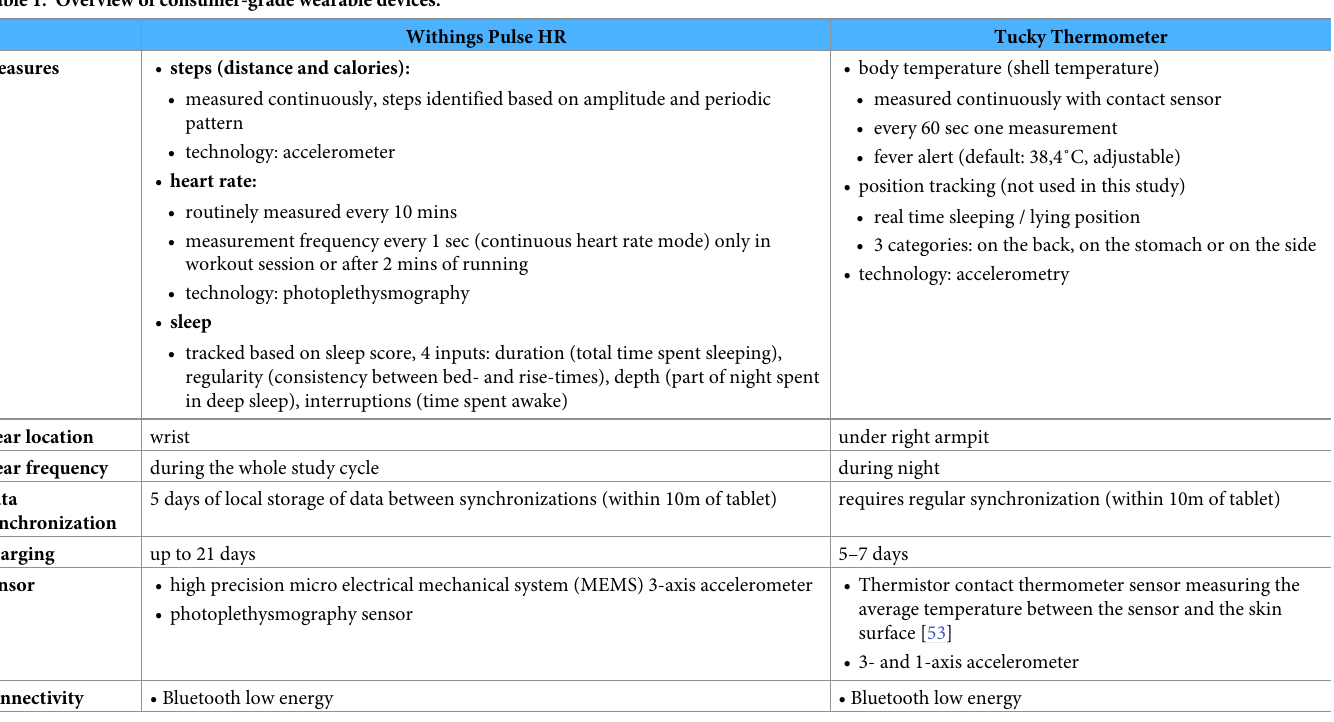
Table 1. Overview of consumer-grade wearable